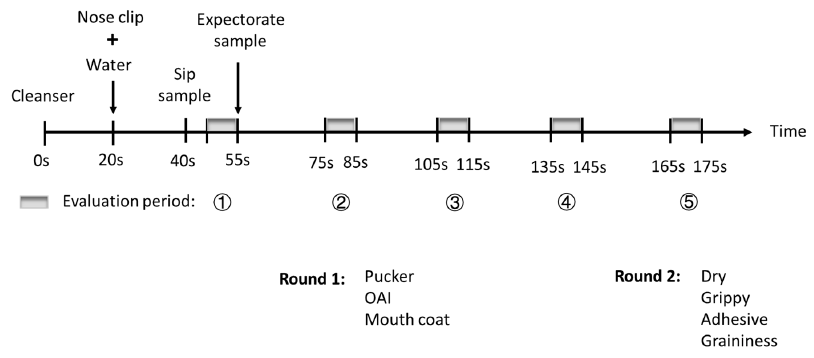
Figure 2. Schematic representation of the modified Progressive Profiling protocol. OAI is overall astringent intensity.